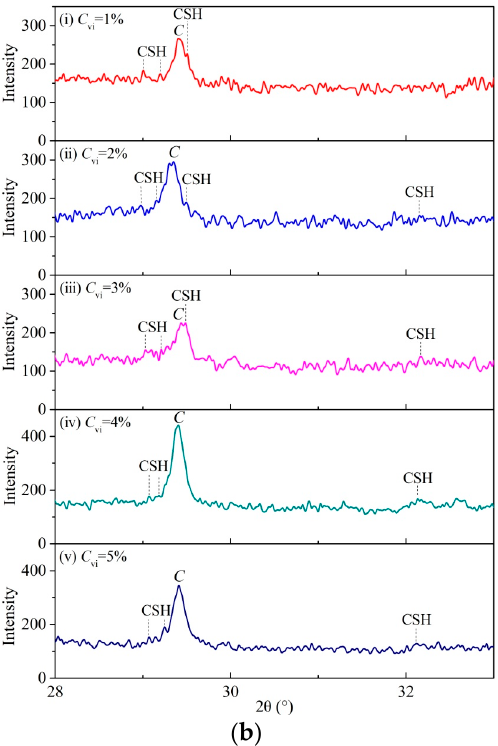
Figure 12. XRD profiles of saturated untreated and cement-treated GRSs cured to 28 d. ( a ) Identification of crystalline minerals; ( b ) Identification of C–S–H.